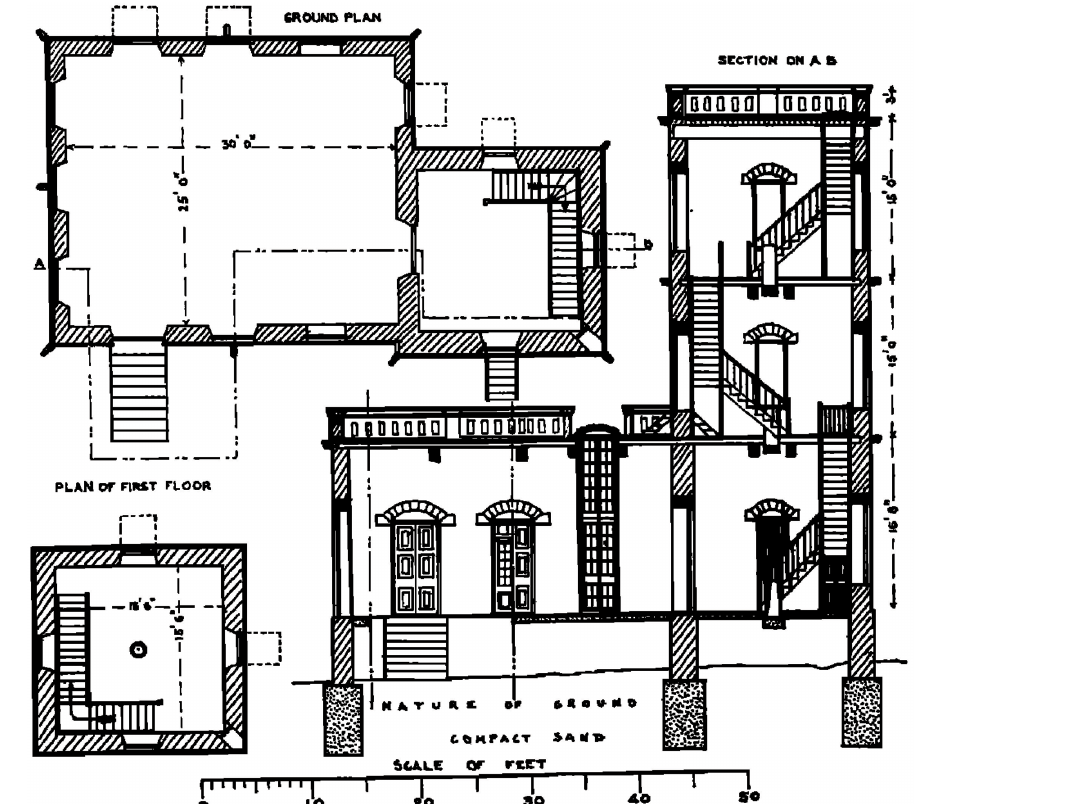
Figure 20. The plan for a magnetometer building that has a basement and two floors (Moos, 1912). This is also called a tower or absolute